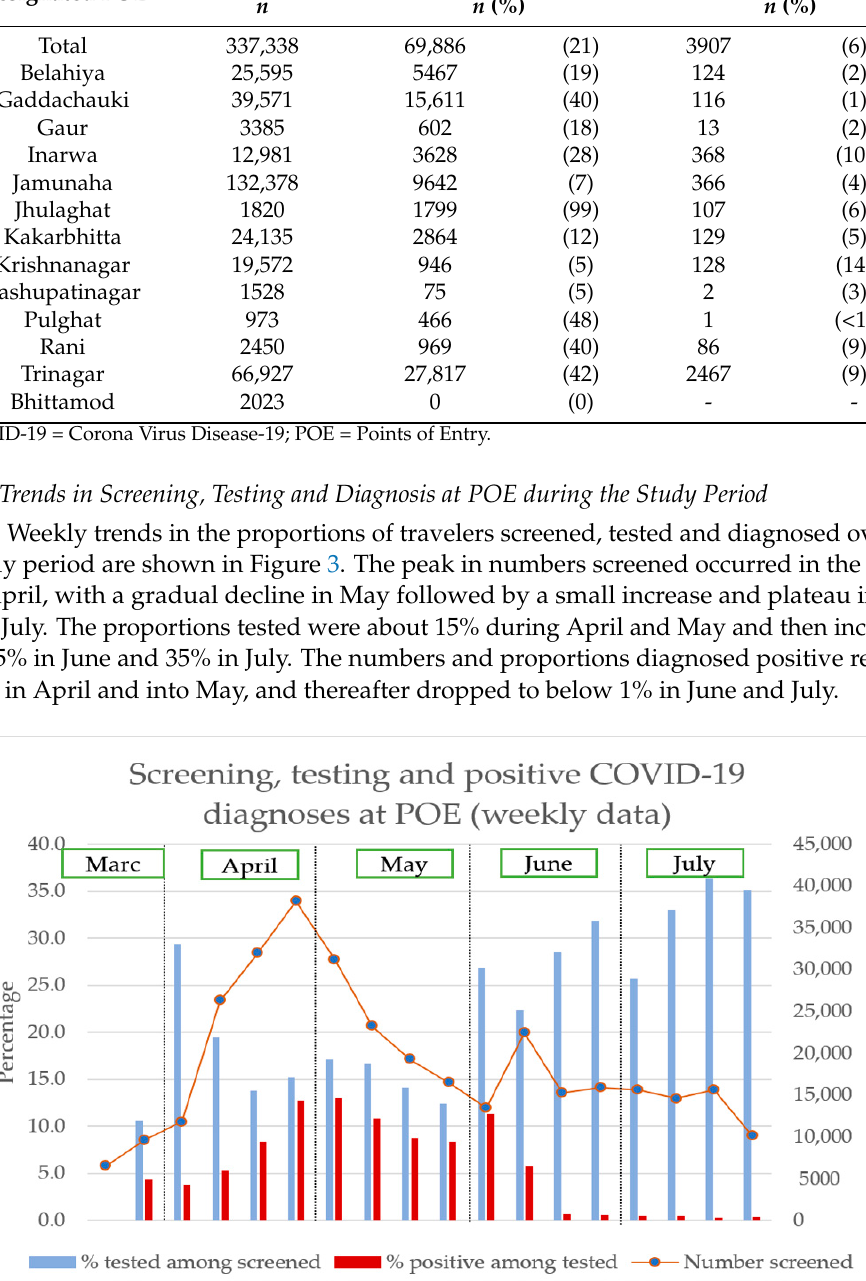
Table 2. Socio-demographic and clinical characteristics of patients diagnosed positive for COVID-